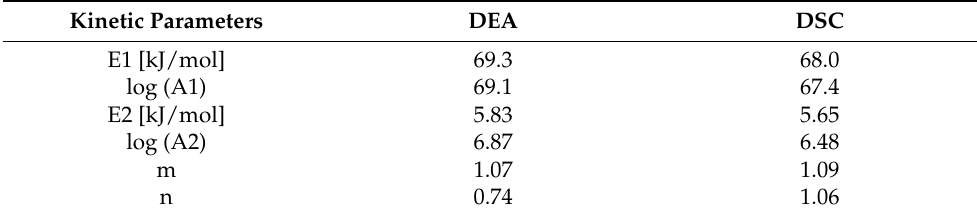
Table 4. Comparison of the kinetic parameters determined by the Kamal-Sourour equation (Equation (11)) via DEA and DSC. Kinetic